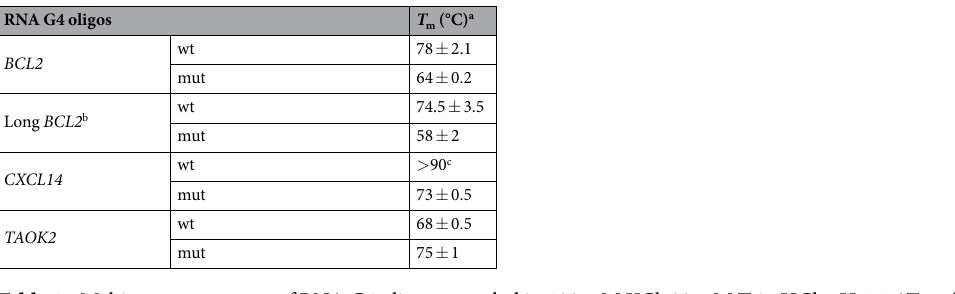
Table 1. Melting temperatures of RNA G4 oligos annealed in 100 mM KCl, 20 mM Tris-HCl, pH 7.5. a T m values are expressed as mean ± SD (n ≥ 2). b Long BCL2 consists of 22 nucleotides predicted to form the RNA G4 and 20 extra nucleotides from each side. c CXCL14 wt RNA G4 oligo could not be completely melted even at 95